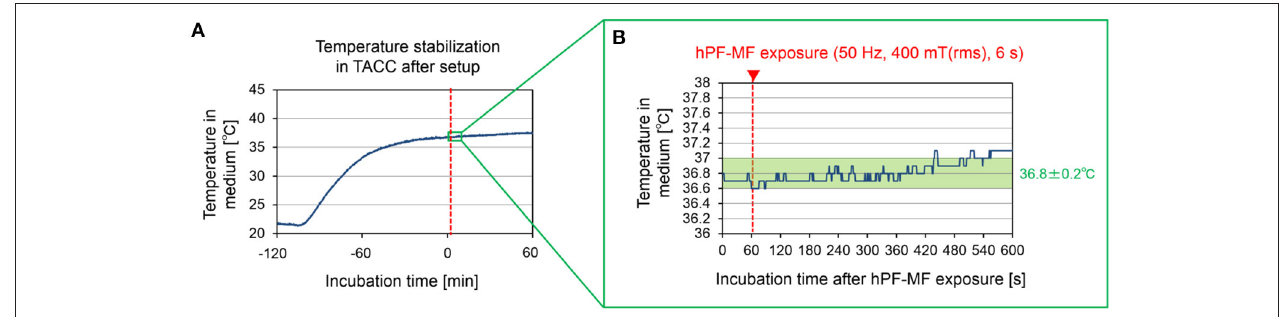
FIGURE 3 | Temperature in the culture medium during the hPF-MF exposure experiment. (A) Temperature change in the culture medium after setting the MEAs dish to the acrylic cell culture chamber. Although the temperature inside the medium decreases with the movement and installation of the MEAs dish, the temperature is stabilized by over 2h of culture in the chamber. (B) Confirmation of temperature change due to magnetic field exposure at temperature stabilization. In this experimental system, it is possible to maintain temperature fluctuation under + 0.2 ◦ C during 7min after 400 mT hPF-MF exposure. TACC: thermostatic acrylic culture